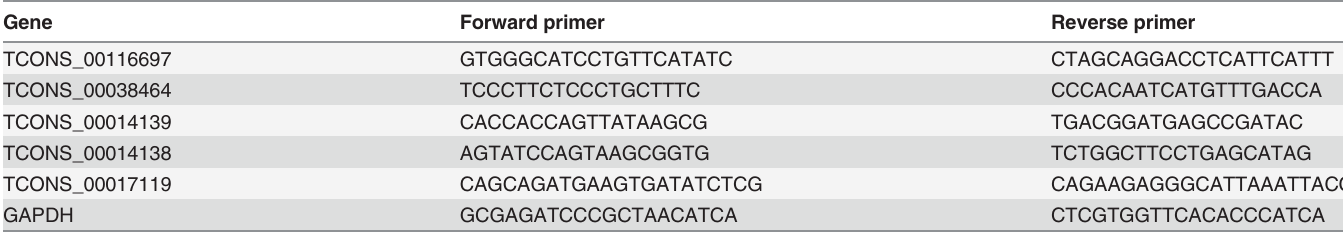
Table 2. Real-Time PCR Primers for 5 lncRNAs and